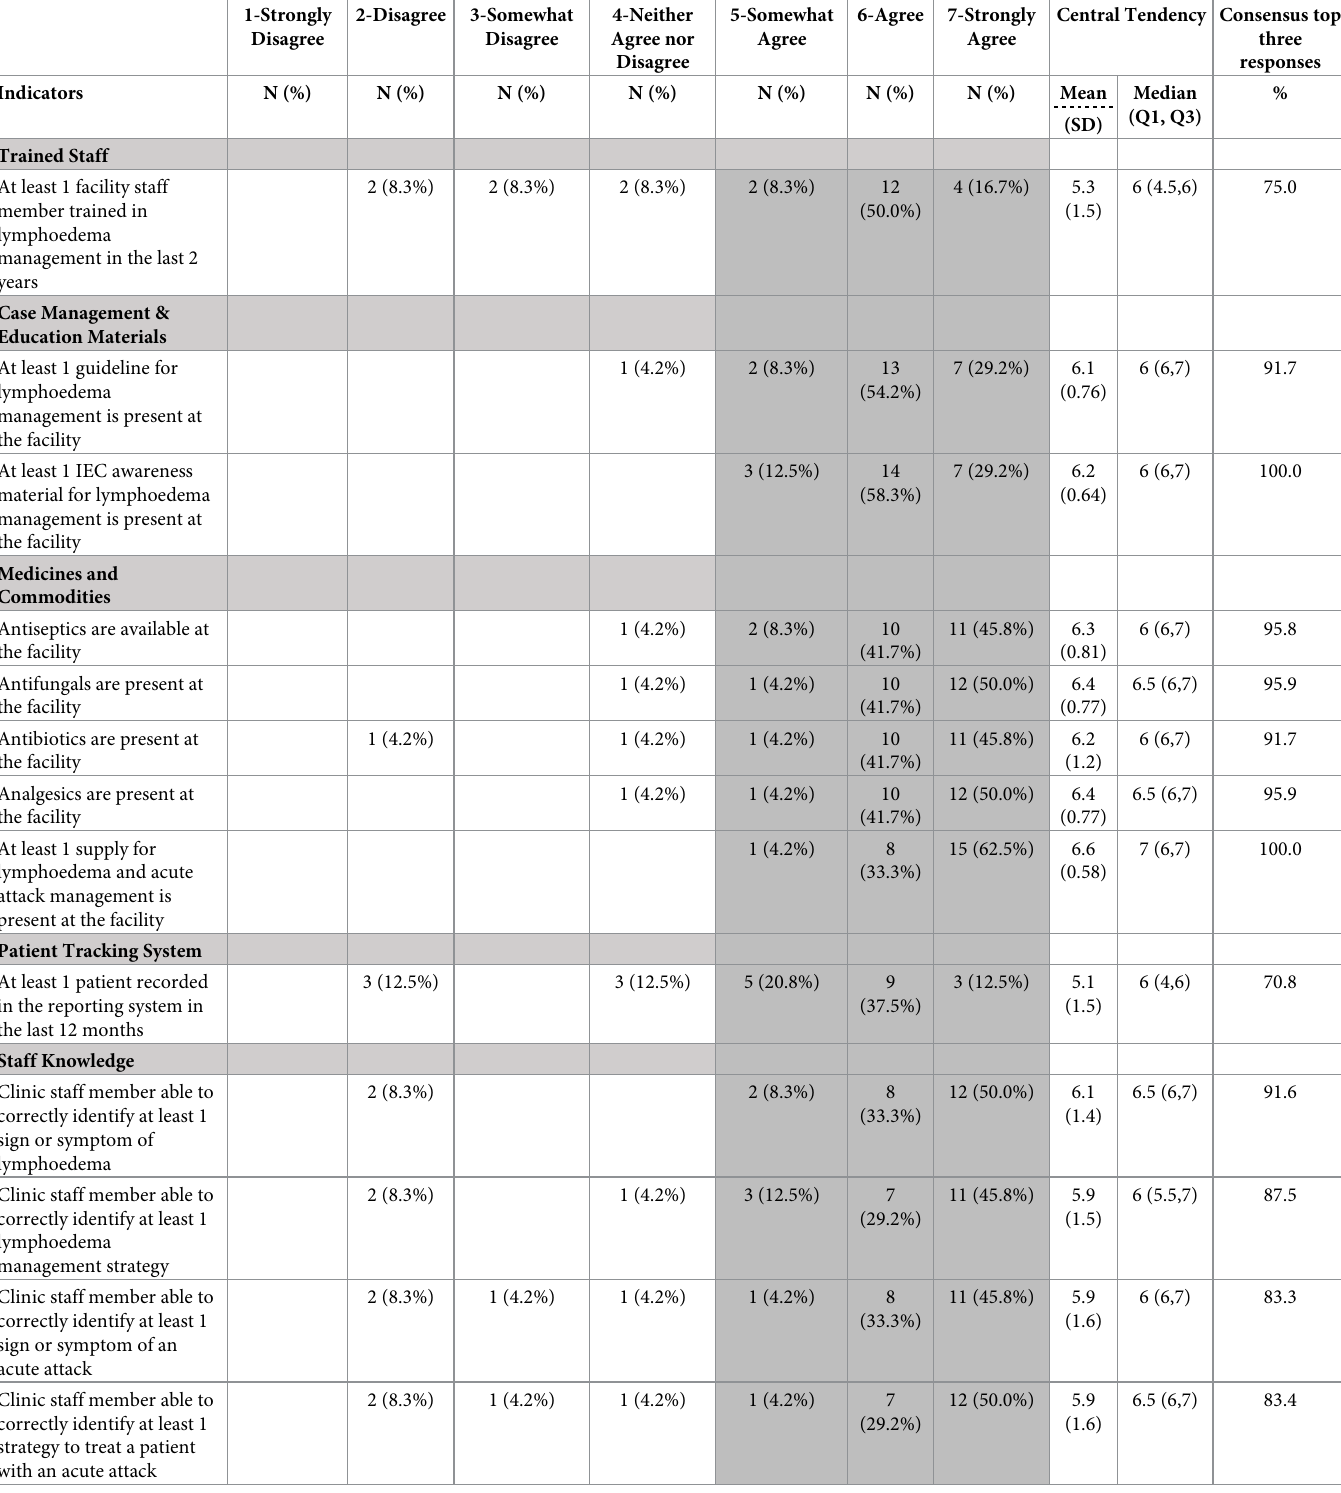
Table 4. Participant response to the question: “The following indicator adequately evaluates the domain ________.” n =